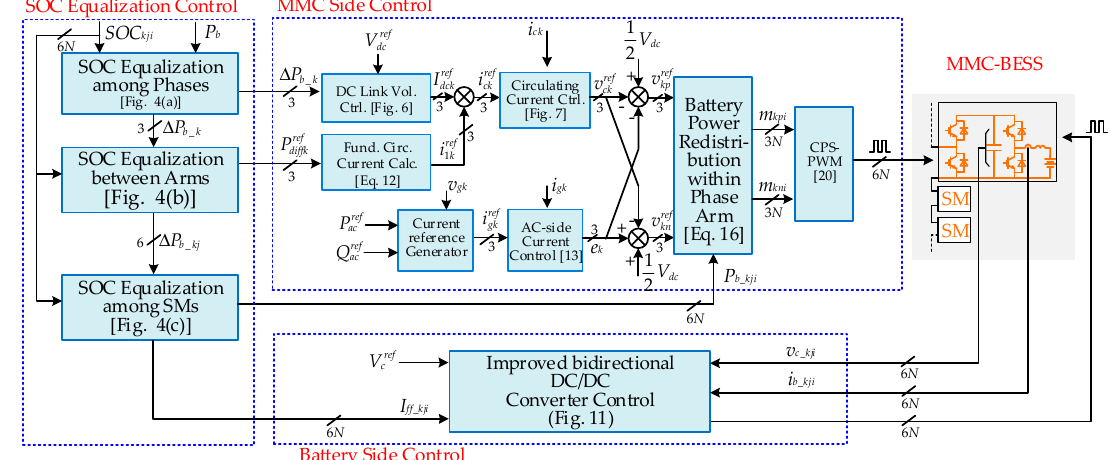
Figure 8. Overall control strategy of the MMC-BESS based on battery side capacitor voltage control.